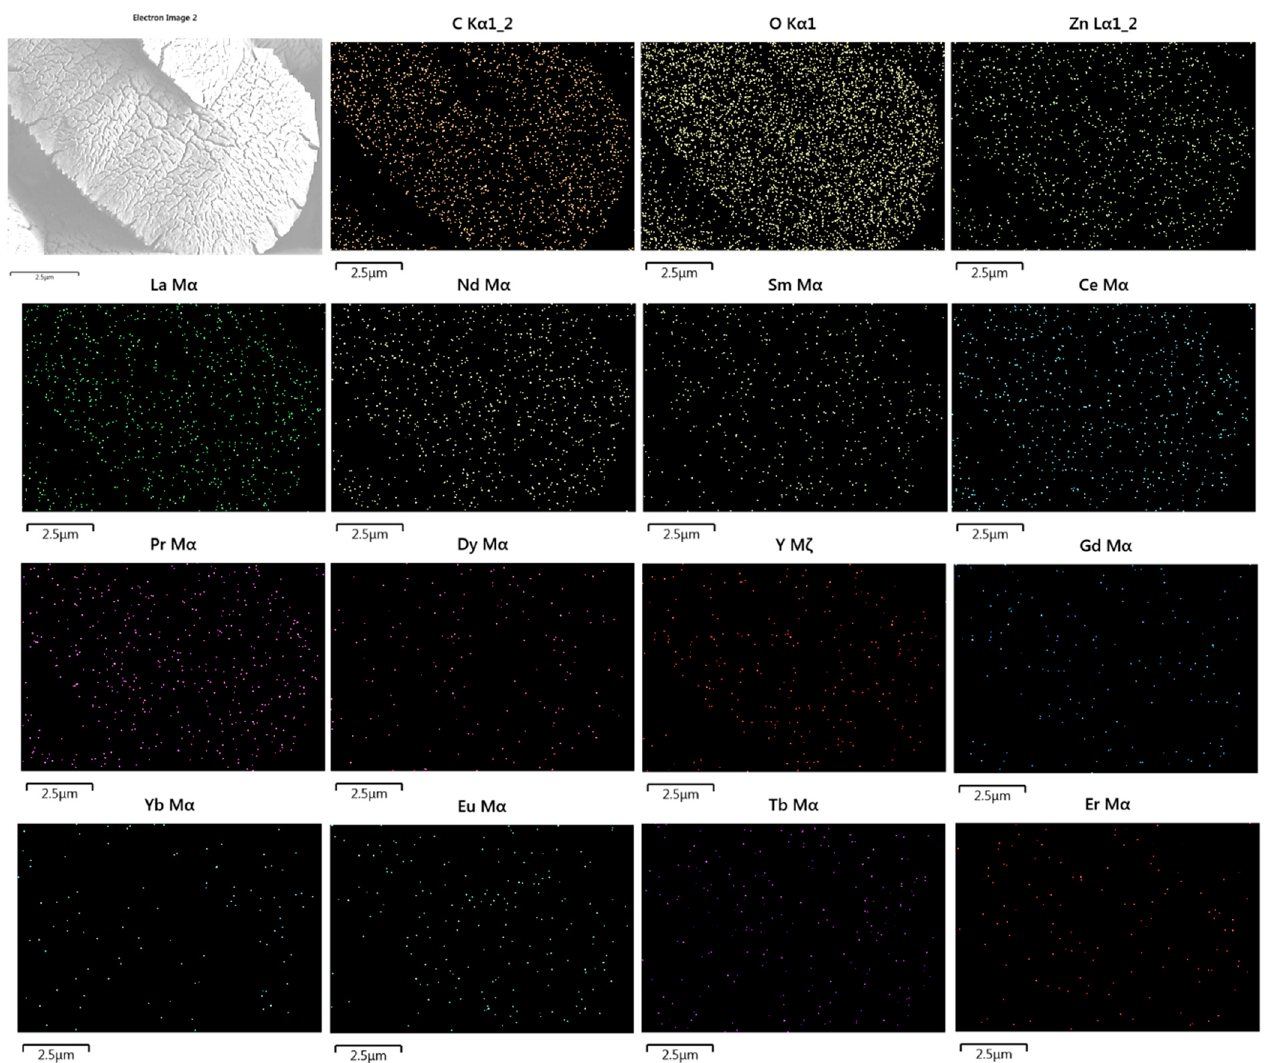
Figure 8. EDS mapping images of the REE precipitate.